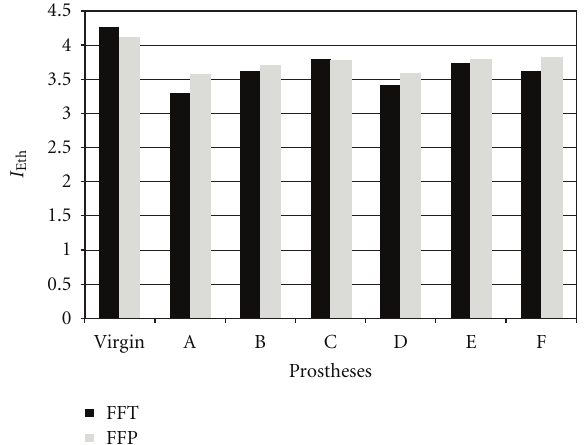
Figure 13: Variation of the ethylene groups for di ff erent prostheses. I ETH is the integral value of the ethylene group